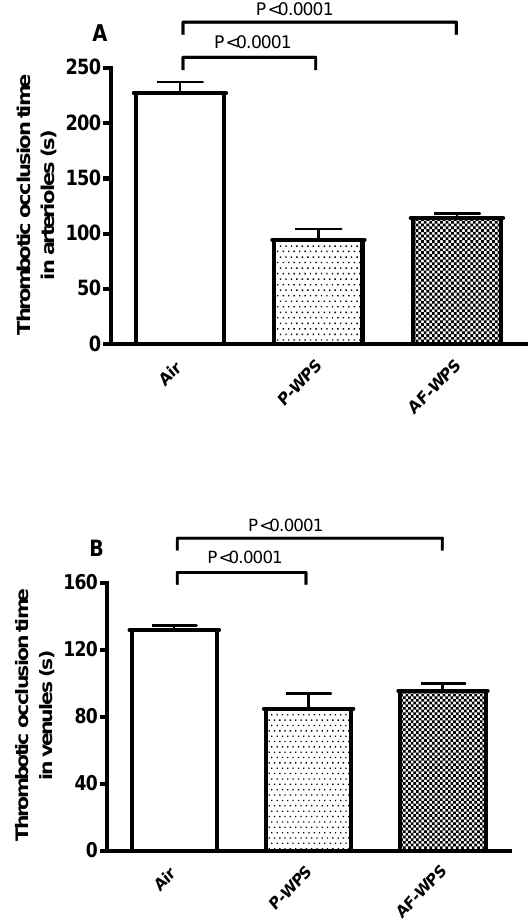
Figure 2. Effects of plain water-pipe smoke (P-WPS) or apple-flavoured (AF)-WPS on thrombosis in vivo. Thrombotic occlusion time in pial arterioles ( A ) and venules ( B ) in mice at the end of 1 mo exposure period to either air or P-WPS or AF-WPS. Data are mean ± SEM (n = 6); one-way ANOVA followed by Holm–Sidak’s multiple comparison test.